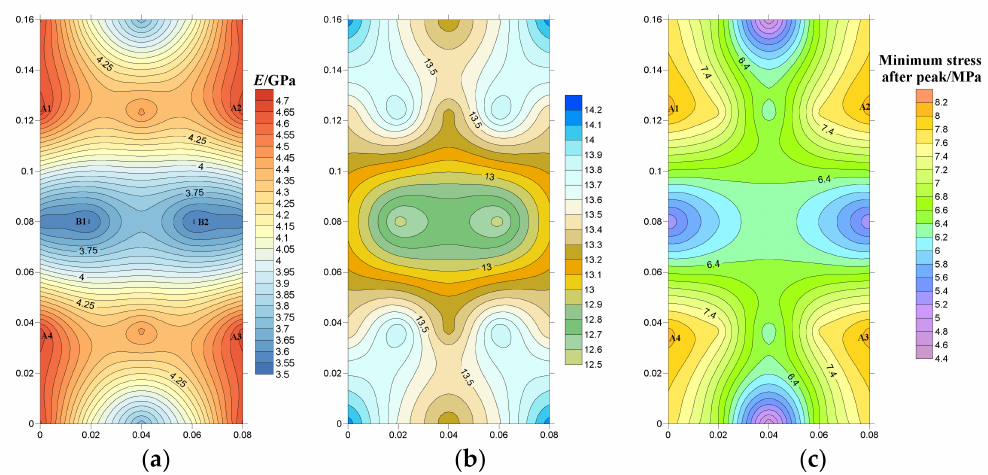
Figure 23. Mechanical properties of different mineral circular positions: ( a ) elasticity modulus, ( b ) UCS, ( c ) minimum stress